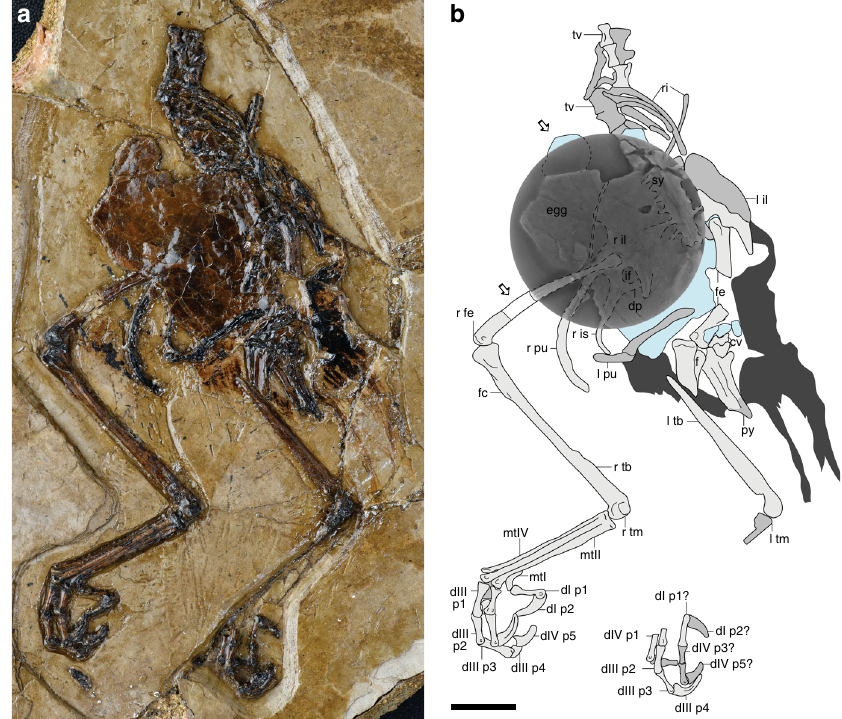
Fig. 1 Photograph and line drawing of the holotype of Avimaia schweitzerae , IVPP V25371. a Photograph of the partial skeleton with feather impressions, and the crushed preserved egg between the pubes; b interpretive line drawing, with white arrows indicating the two fragments extracted for microscopic analysis with a super-imposed CT-scan revealing the egg and underlying elements of the right pelvis in dorsal (synsacrum) and medial (ilium) view. Gray denotes bones (darker gray indicating poor preservation), blue denotes the egg, and dark gray denotes feather impressions. cv caudal vertebra, d digit, dp dorsal process, f fi bula, fc fi bular crest, fe femur, if ilioischiadic foramen, il ilium, is ischium, l left, mt metatarsal, p pedal phalanx, pu pubis, py pygostyle, r right, ri rib, sy synsacrum, tb tibiotarsus, tm tarsometatarsus, tv thoracic vertebra. Scale bar is 1